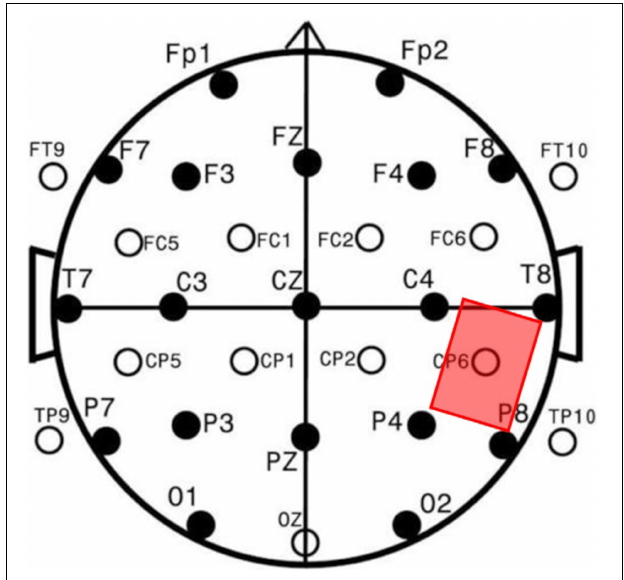
FIGURE 1 | The location of the anodal electrode in the